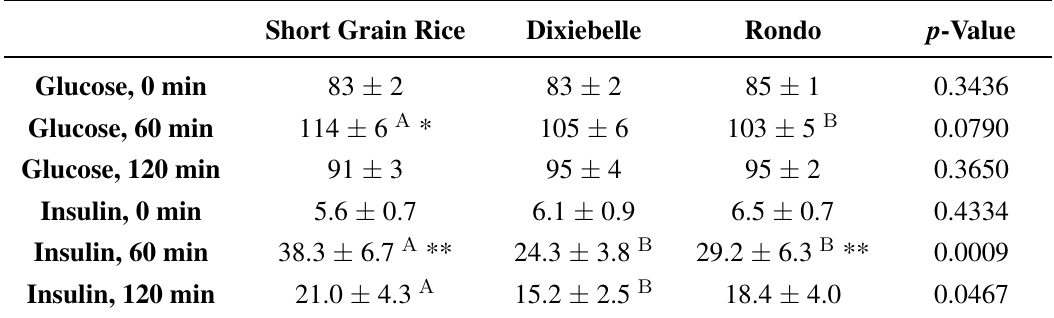
Table 4. Venous blood glucose (mg/dL, mean ± SEM) and insulin ( µ IU/mL, mean ± SEM) values before (0 min) and after treatment intake in healthy adults ( n =